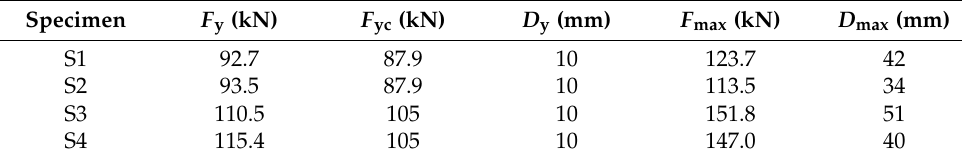
Table 2. Characteristics of the envelope curve of the